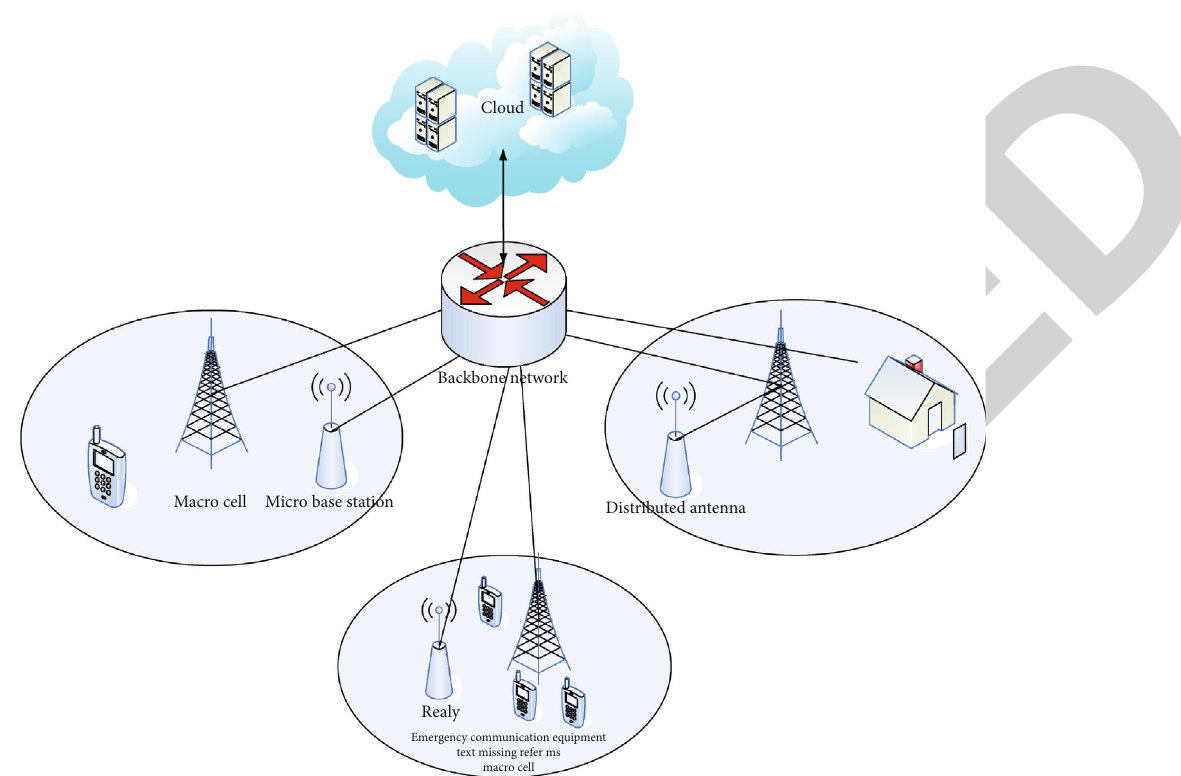
Figure 1: Educational service architecture under 5G communication